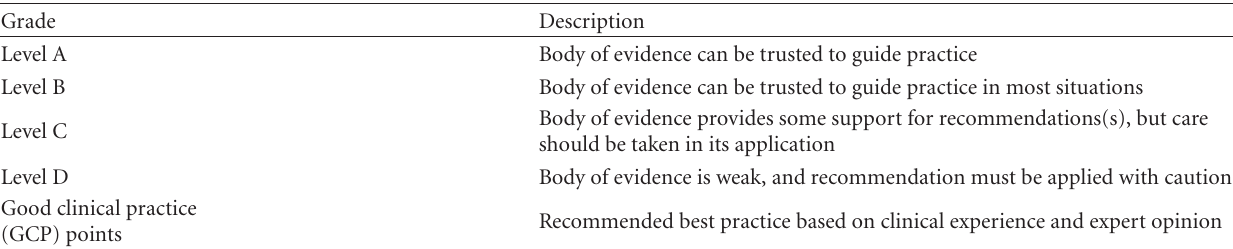
Table 5: Gradings of